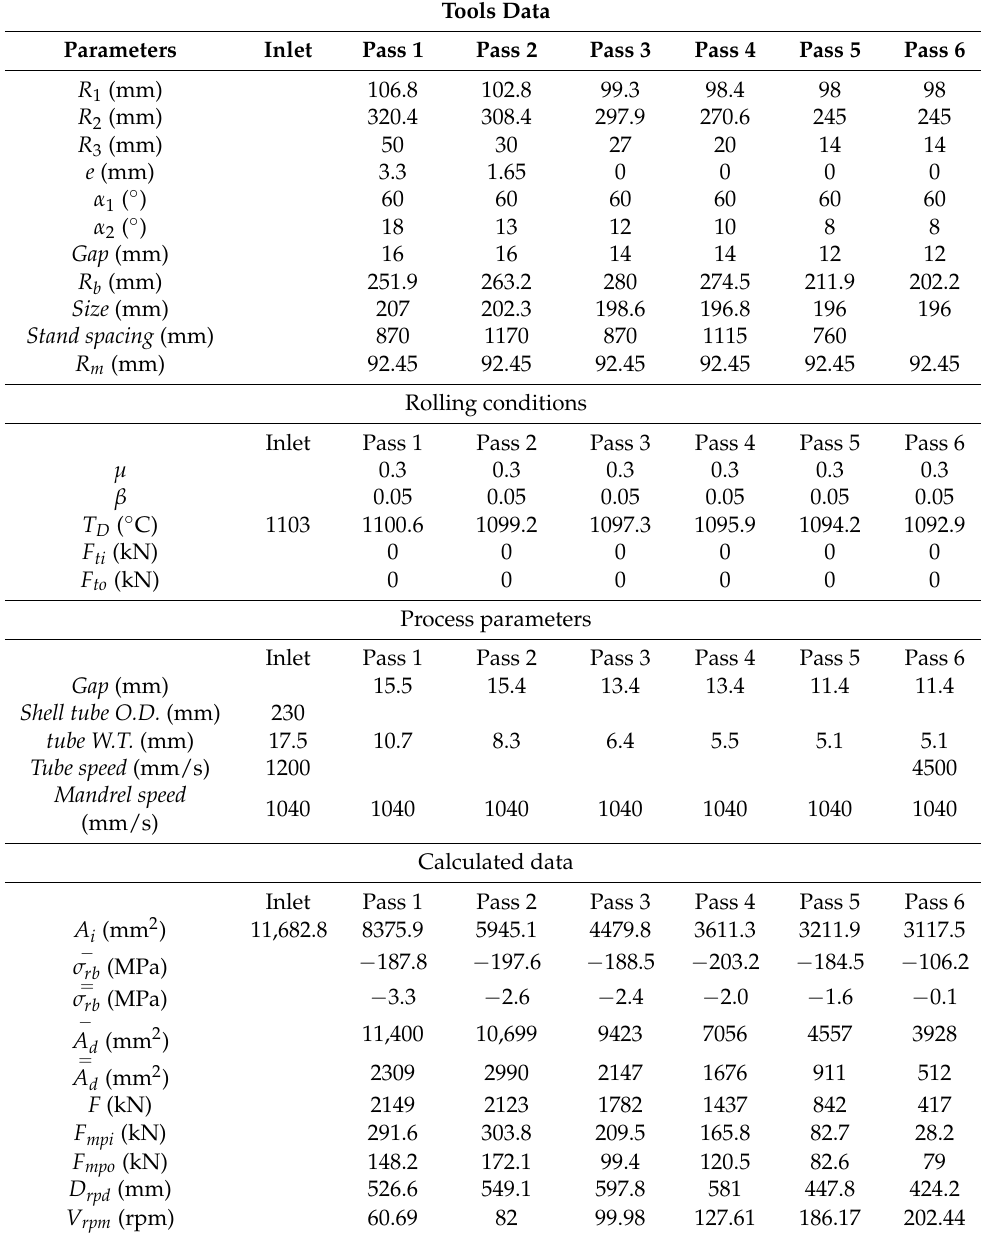
Table 2. Primary data of a calculation